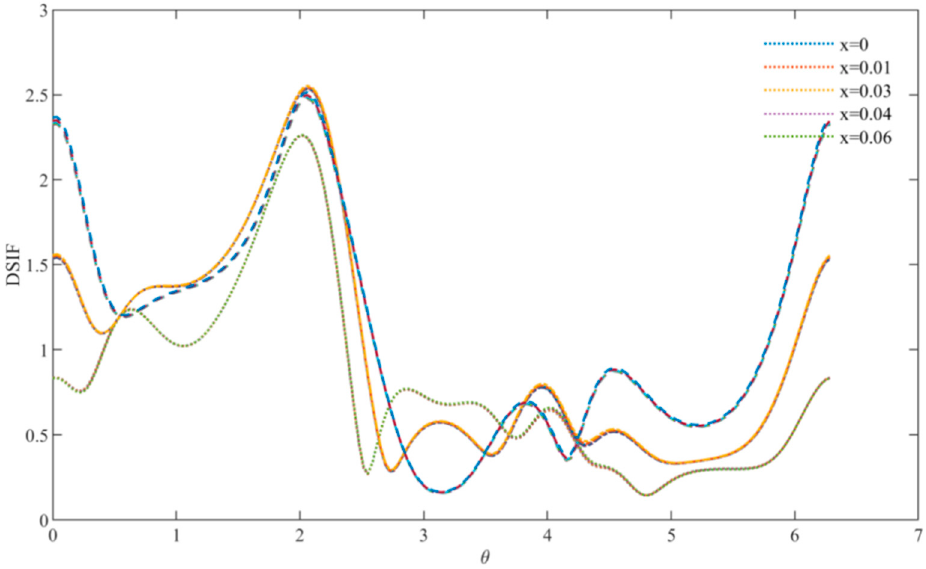
Figure 6. Comparison diagram of DSCF distribution at high frequency ( ka = 3, 3.5, 4).